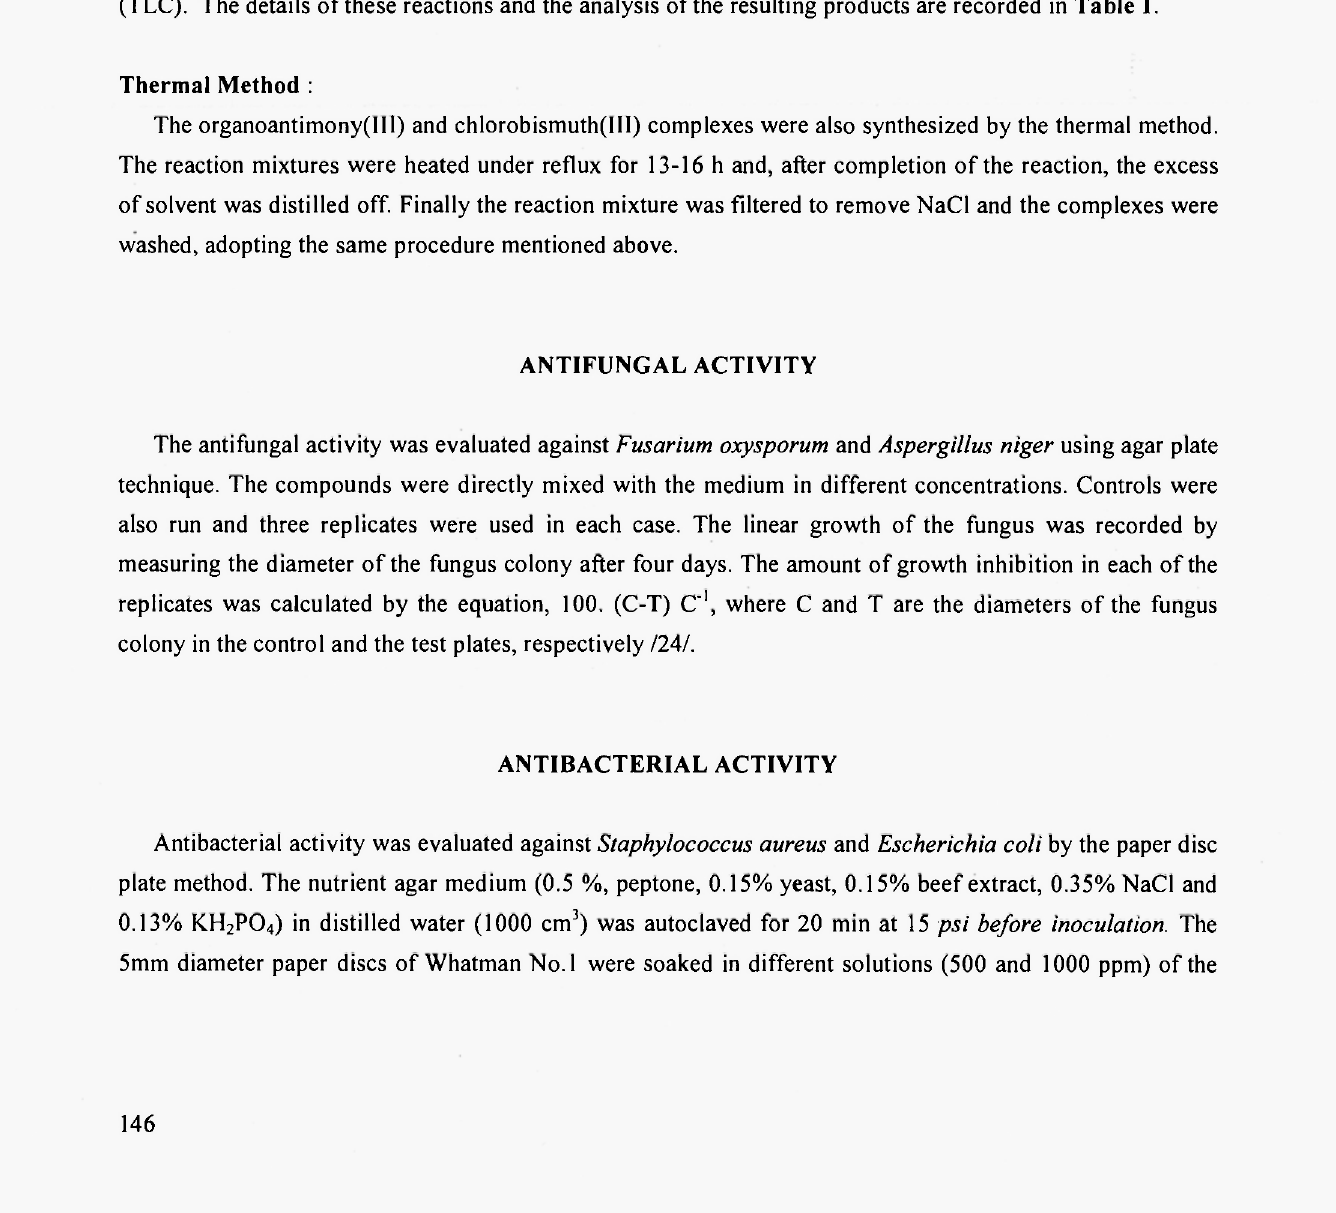
(1) Preparation of the organoantimony(III) and chlorobismuth(IU) complexes: Microwave Method : For the synthesis of these complexes, dichloromonophenyl antimony(lll), diphenylmonochloroantimony(III) and chlorobismuthane(III) and the sodium salts of the ligands in 1:1:1 and 1:1:2 molar ratios were irradiated inside a microwave oven at 700 W for about 10-15 min. The products were recovered from the microwave oven and dissolved in a few mL of dry methanol. The white precipitate of sodium chloride formed during the course of the reaction was removed by filtration and the filtrate was dried under reduced pressure. The resulting product was repeatedly washed with petroleum ether and then finally dried at 40-60 °C / 0.5 mm Hg for 3-4 h. The purity was further checked by thin-layer chromatography (TLC). The details of these reactions and the analysis of the resulting products are recorded in Table 1.